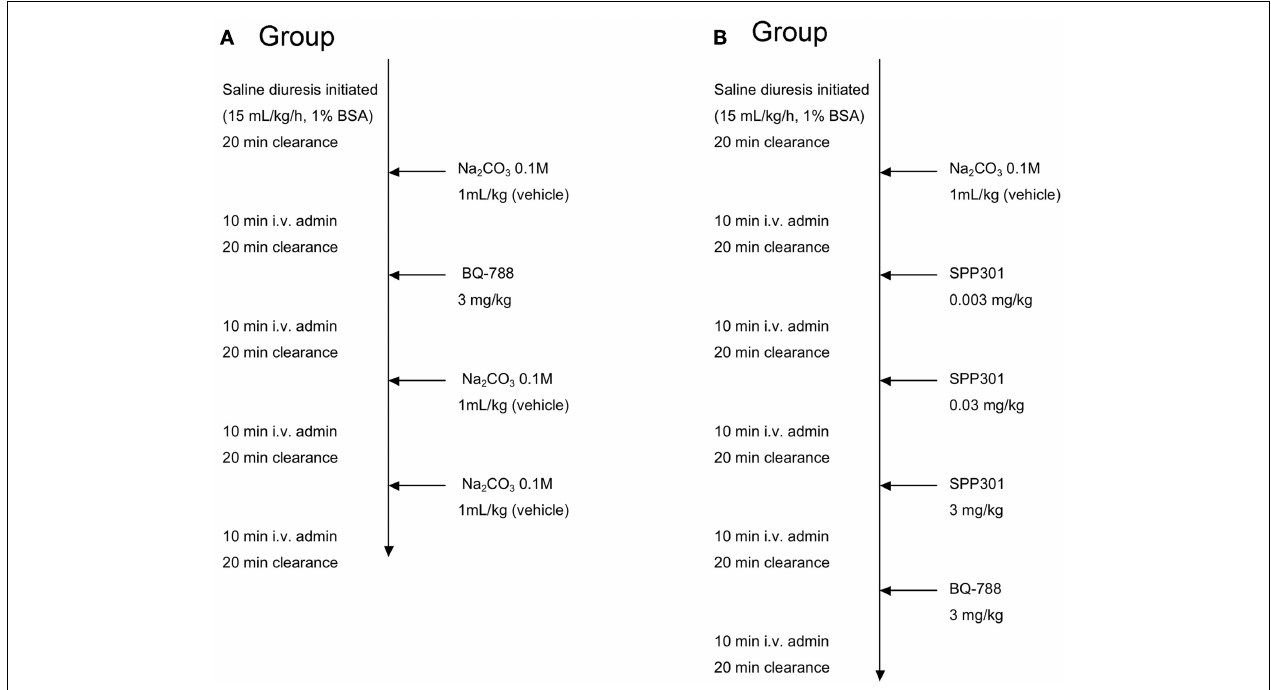
FIGURE 1 | Study design. Group A study design: i.v. administration of BQ-788 (3mg/kg) to anesthetized male SD rats undergoing saline diuresis. Group B study design: i.v. administration of incremental doses of SPP301 (0.003; 0.03; 3mg/kg) followed by BQ-788 (3mg/kg) to anesthetized male SD rats undergoing saline